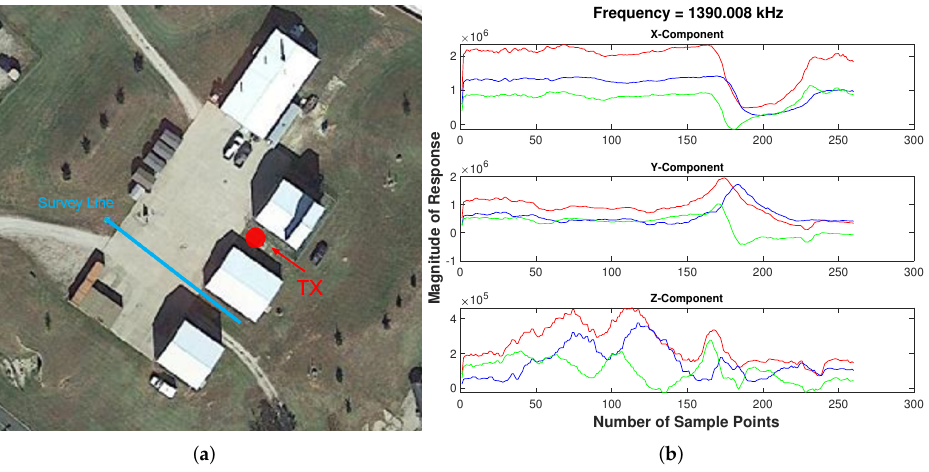
Figure 15. Concrete environment testing. ( a ) Overhead view of survey site. ( b ) Results from existing EM field—red and blue lines plot the response from the front and back gradiometer receivers, respectively. The green line plots the magnitude of the front RX subtracted by the magnitude of the back